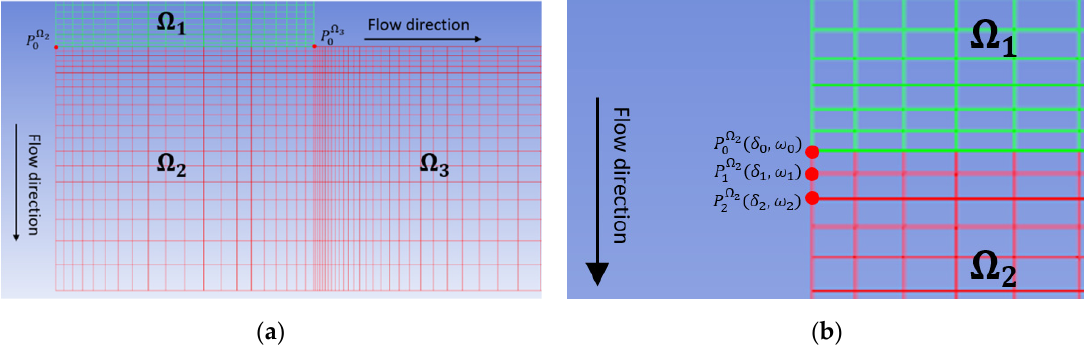
Figure 4. Free surface remeshing by streamline-wise method: ( a ) dividing the deposition flow into two subdomains; ( b ) example of applying the remeshing approach to free surface of Ω 2